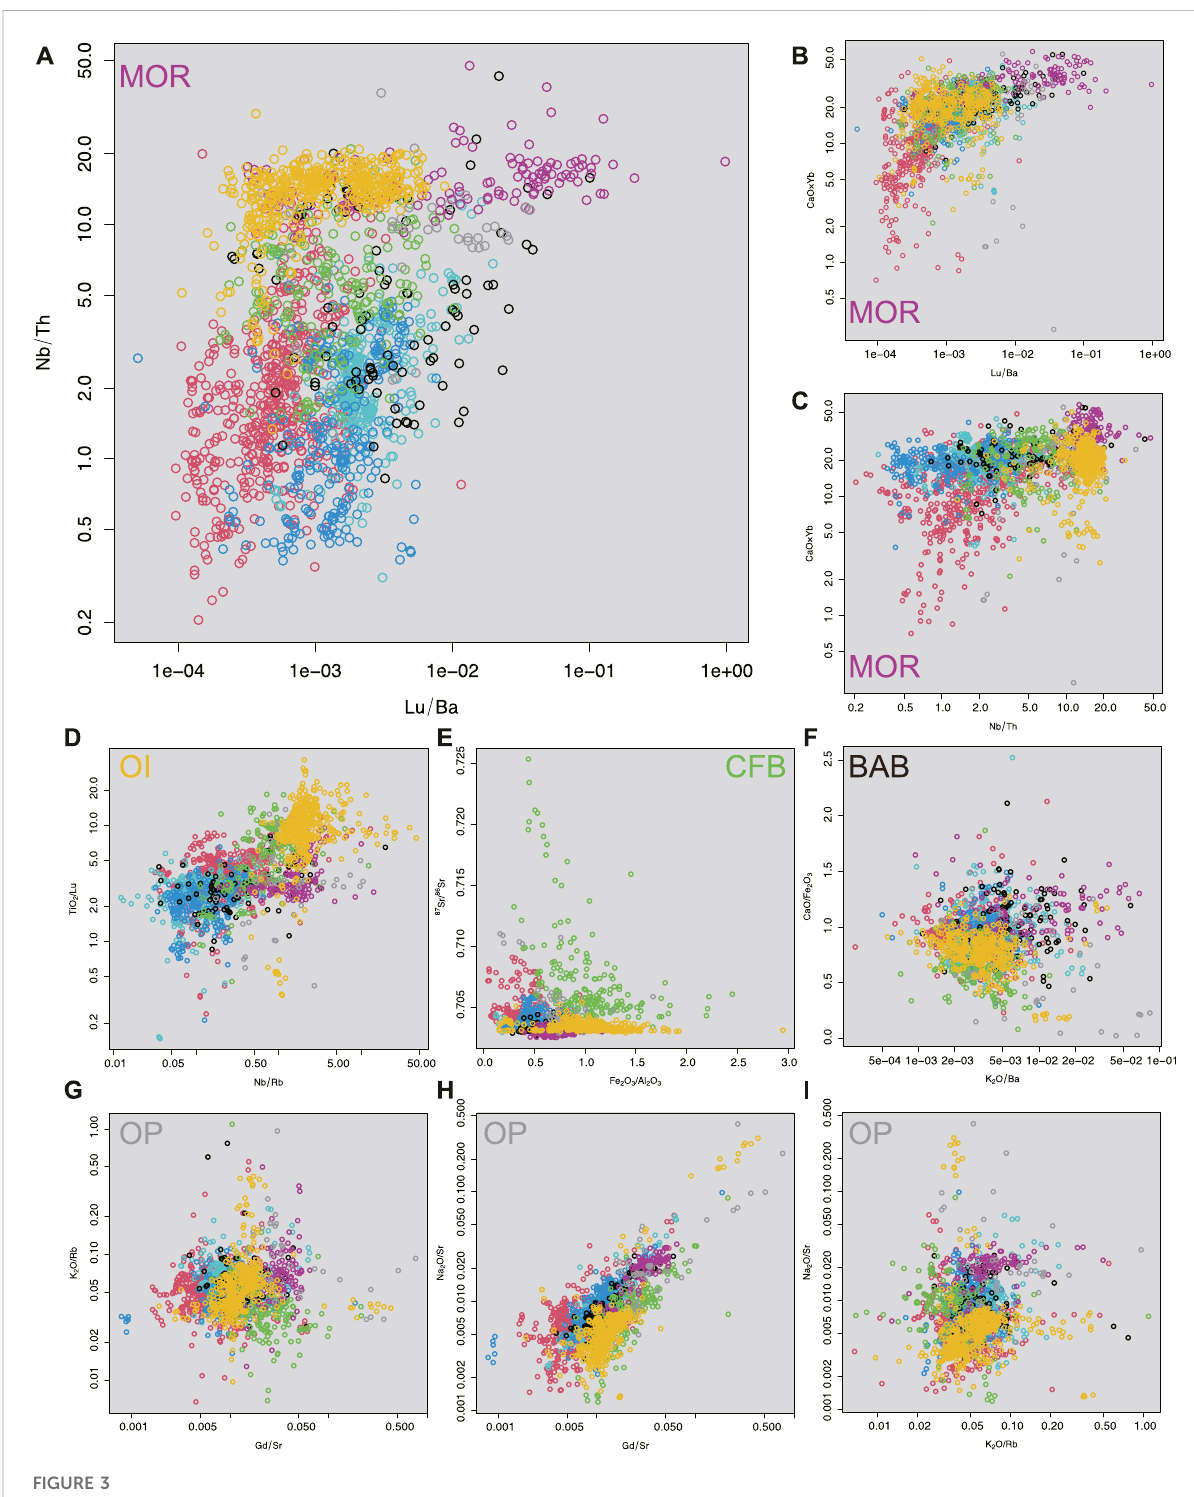
FIGURE 3 Bivariate plots of the key geochemical features (Table 1) of the MOR, OI, CFB, BAB, and OP settings. Symbols are as in Figure 2 (A – C) Geochemical features selected from MOR settings (Lu/Ba, Nb/Th, and CaO×Yb). Samples at upper right exhibit a more MOR-like signature. (D) Geochemical features selected from OI settings (Nb/Rb and TiO 2 /Lu). Samples at upper right exhibit a more OI-like signature. (E) Geochemical features selected from CFB settings (Fe 2 O 3 /Al 2 O 3 and 87 Sr/ 86 Sr). Samples at upper right exhibit a more CFB-like signature. (F) Geochemical features selected from BAB settings(CaO/Fe 2 O 3 and K 2 O/Ba). Samples atupper right exhibit amore BAB-like signature. (G – I) Geochemicalfeatures selected from OP settings (Gd/Sr, K 2 O/Rb, and Na 2 O/Sr). Samples at upper right exhibit a more OP-like